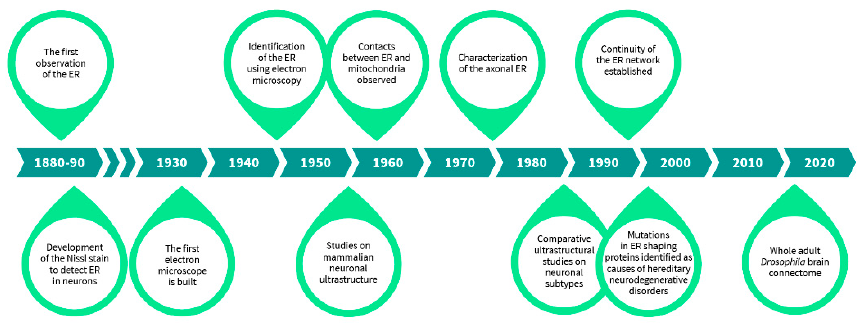
Figure 1. Historical timeline of research on neuronal ER.